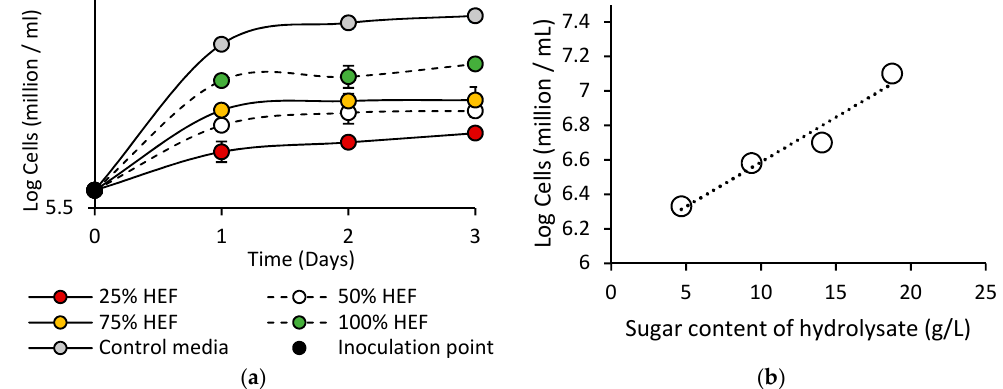
Figure 3. Growth of Metschnikowia pulcherrima in HEF substrate obtained from the fermentation of SCG. Where ( a ) is the logarithm of the number of cells per mL obtained over three days, and ( b ) shows the final cell count as a function of the initial sugar loading in the hydrolysate.